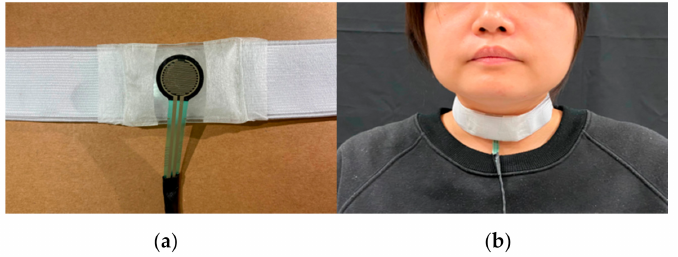
Figure 4. Force-sensing resistor (FSR) measurement: ( a ) FSR with an elastic belt, ( b ) placement of the FSR